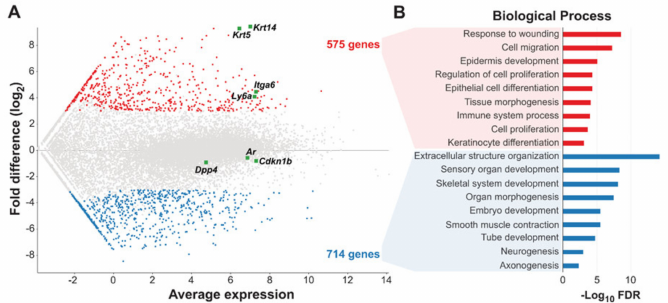
Figure 3. Gene expression profiling of three individual TRAMP tumors reveals distinct epithelial and neuroendocrine signatures for basal and luminal TRAMP tumor cells. ( A ) MA plot showing differentially expressed genes between basal (red) and luminal (blue) cells. Each dot represents a unique transcript. X -axis: average transcript expression, Y -axis: log2 difference in gene expression. ( B ) Barplots showing enriched biological processes in basal-specific (blue) and luminal-specific (red) genes ranked by − Log10